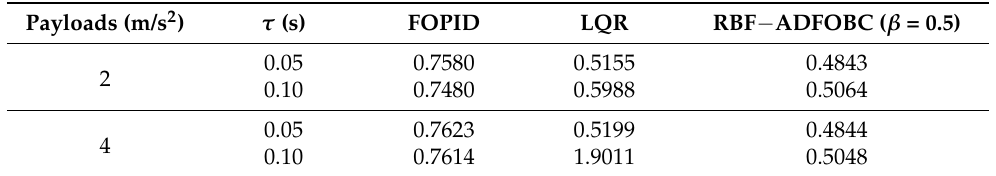
Table 19. Root mean squared error (RMSE) of the simulated tracks under different payloads and different input time delays for the three different controllers.